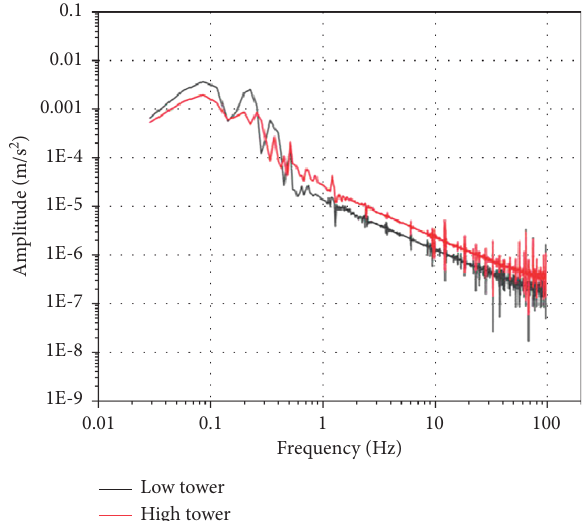
Figure 17: Comparison of vertical vibration acceleration fre- quency-domain curves at L4 and